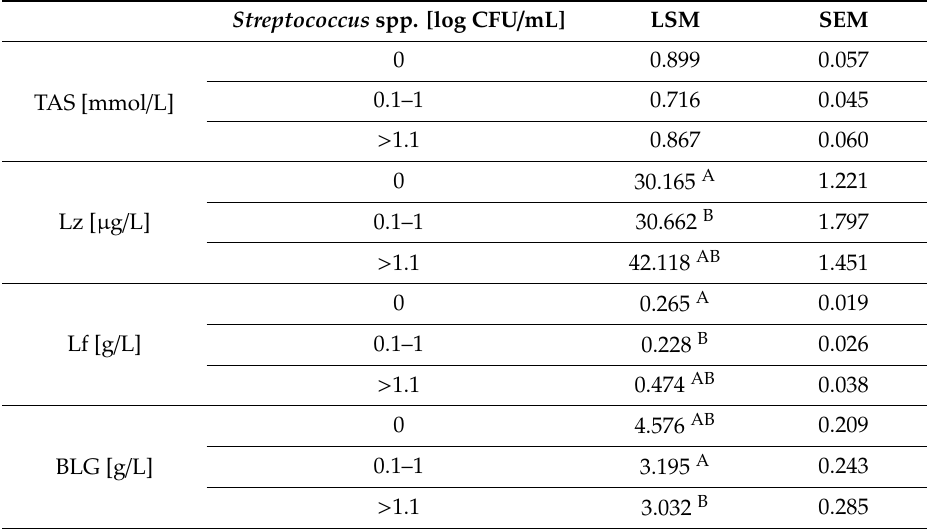
Table 4. Association of Streptococcus spp. with changes in whey proteins and TAS content. Streptococcus spp. [log CFU / mL]